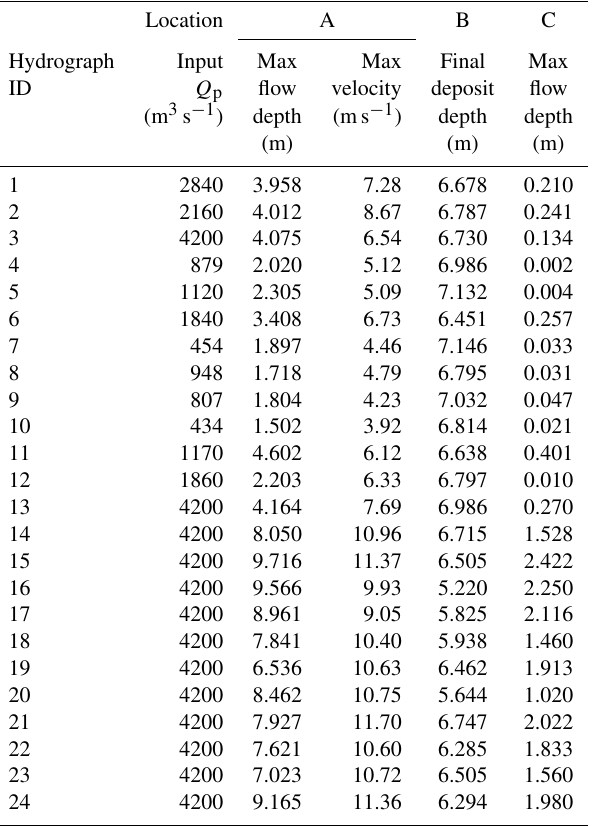
Table A4. Summary of outputs for the Currie D simulations using f = 0 . 13, ξ = 200ms − 2